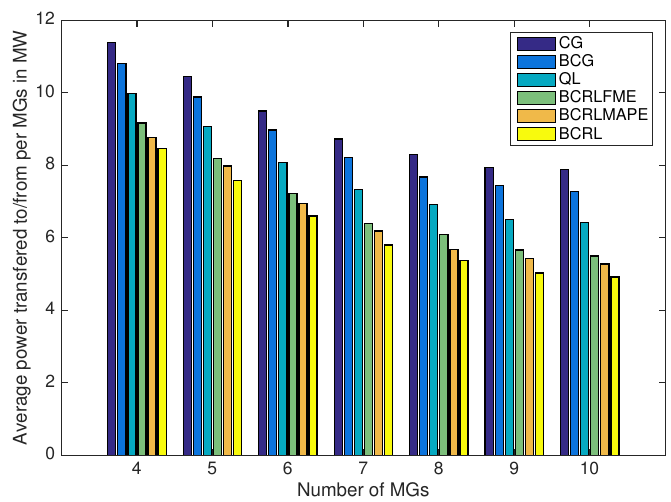
Figure 6. Average energy transfer with macrogrid versus number of microgrids.